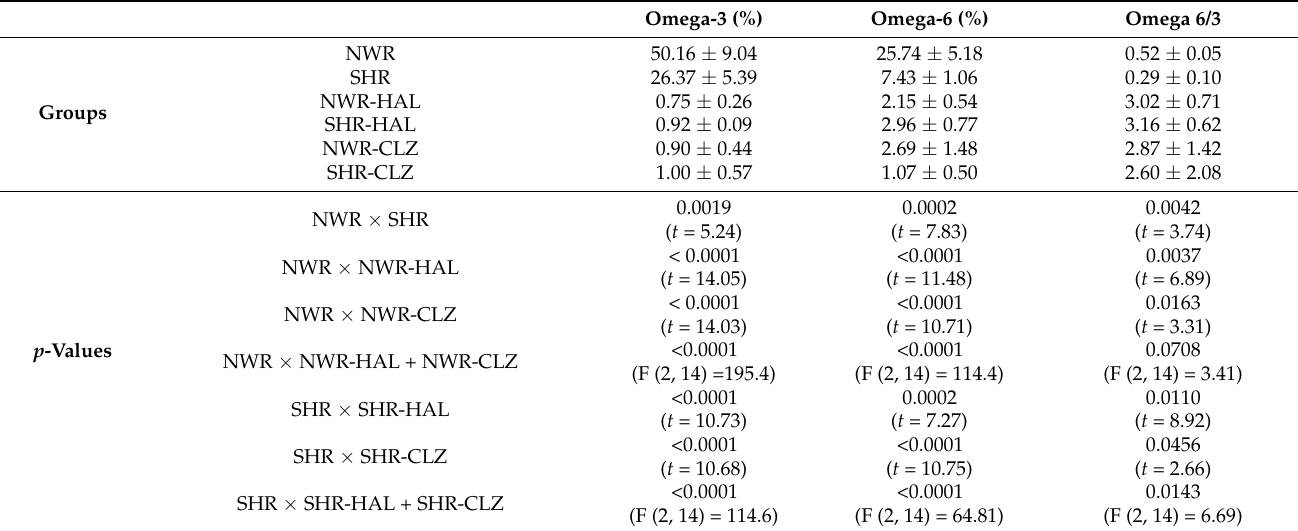
Table 3. Changes in omega-3 and omega-6 determined by 1 H-NMR in NWR and SHR after the treatment with (typical or atypical) antipsychotic drugs (mean values ±